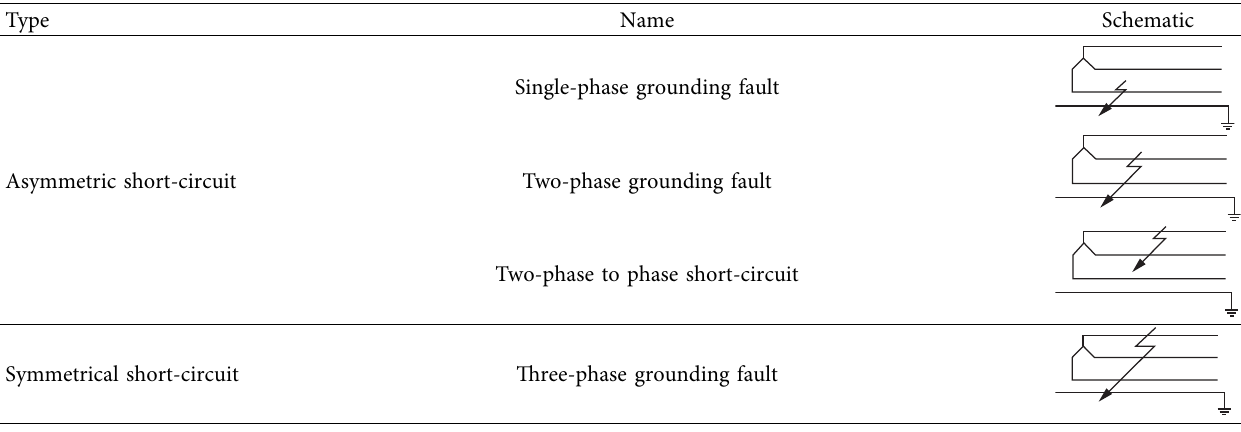
Table 1: Short-circuit fault